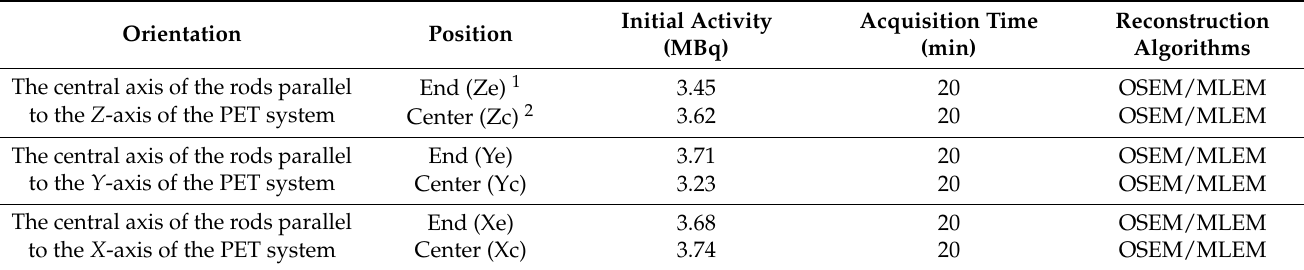
Figure 3. Photograph of the micro-Derenzo phantom (end view). The sizes of the porous arrays in the counterclockwise orientation from small to large are 0.5, 0.6, 0.7, 0.8, 0.9, and 1.0 mm. The center-to-center distance between adjacent rods is twice the rod diameter. Table 2. The six sub-experiments in the measurement of the PET/CT system spatial resolution using a micro-Derenzo